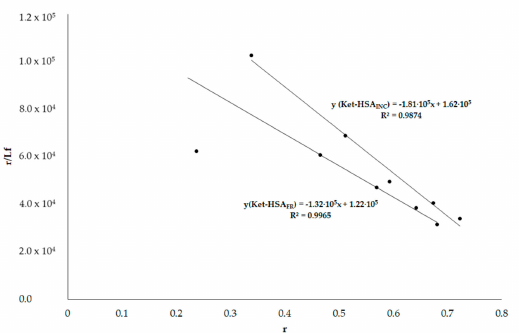
Figure 10. Scatchard curve for Ket–HSA FR and Ket–HSA INC systems; λ ex 275